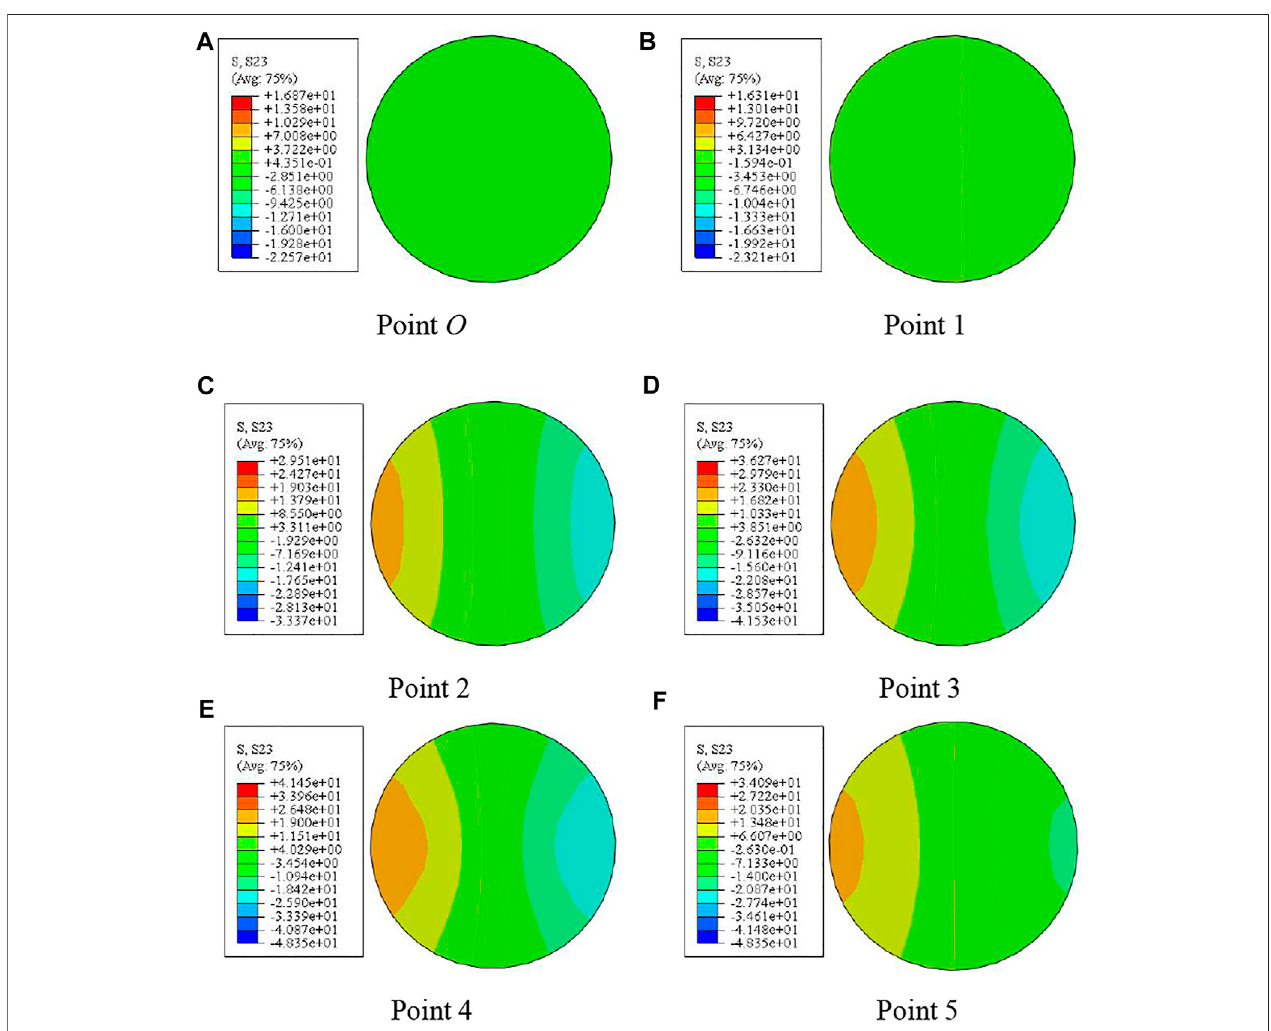
FIGURE 20 | Shear stress distribution of the section concrete. (A – F) crack of Shear stress distribution of the section concrete at different 0 – 5 points.